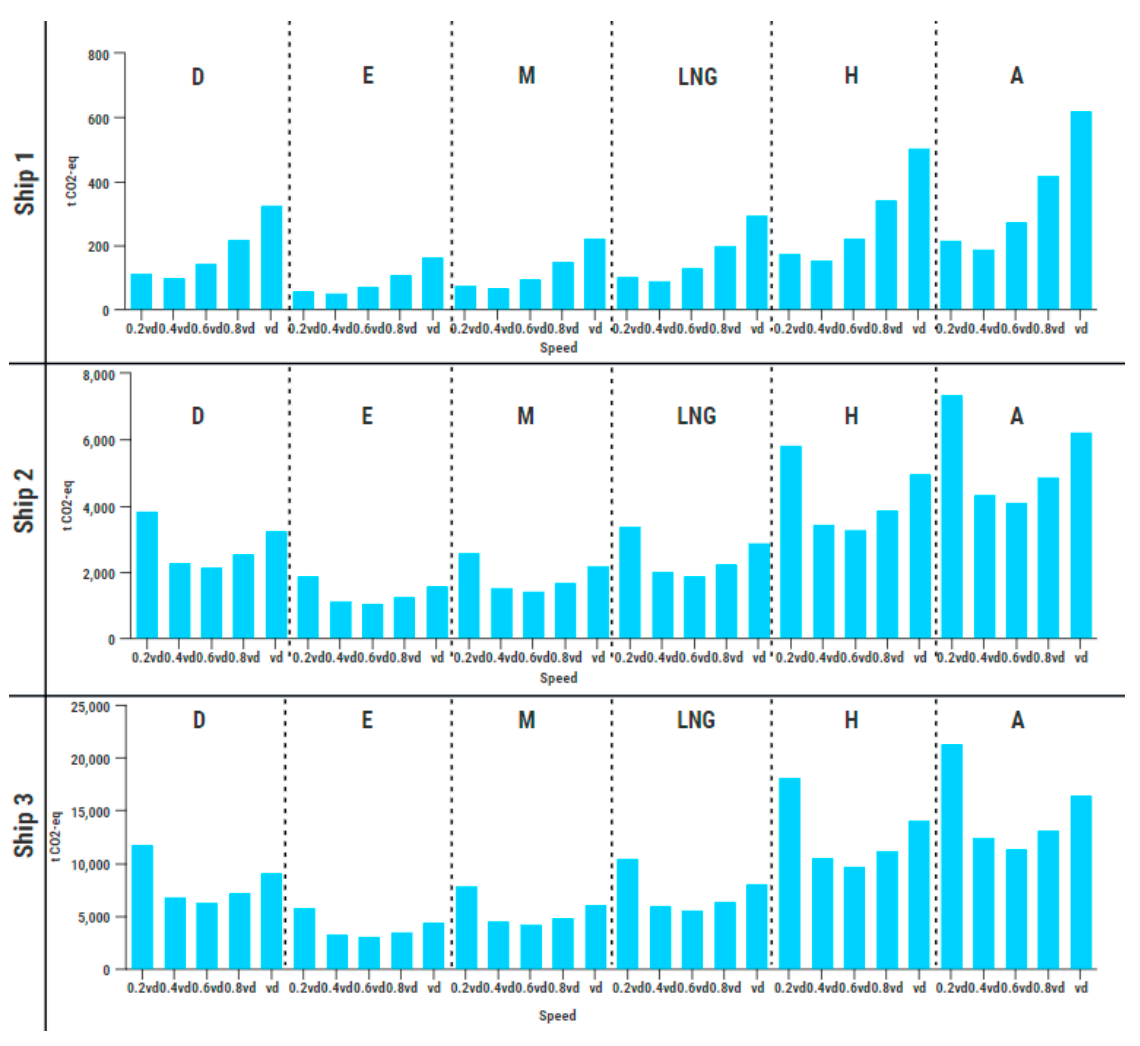
Figure 6. Impact of speed reduction on annualCO 2 -eq emissions of ships with different power sys- tems.